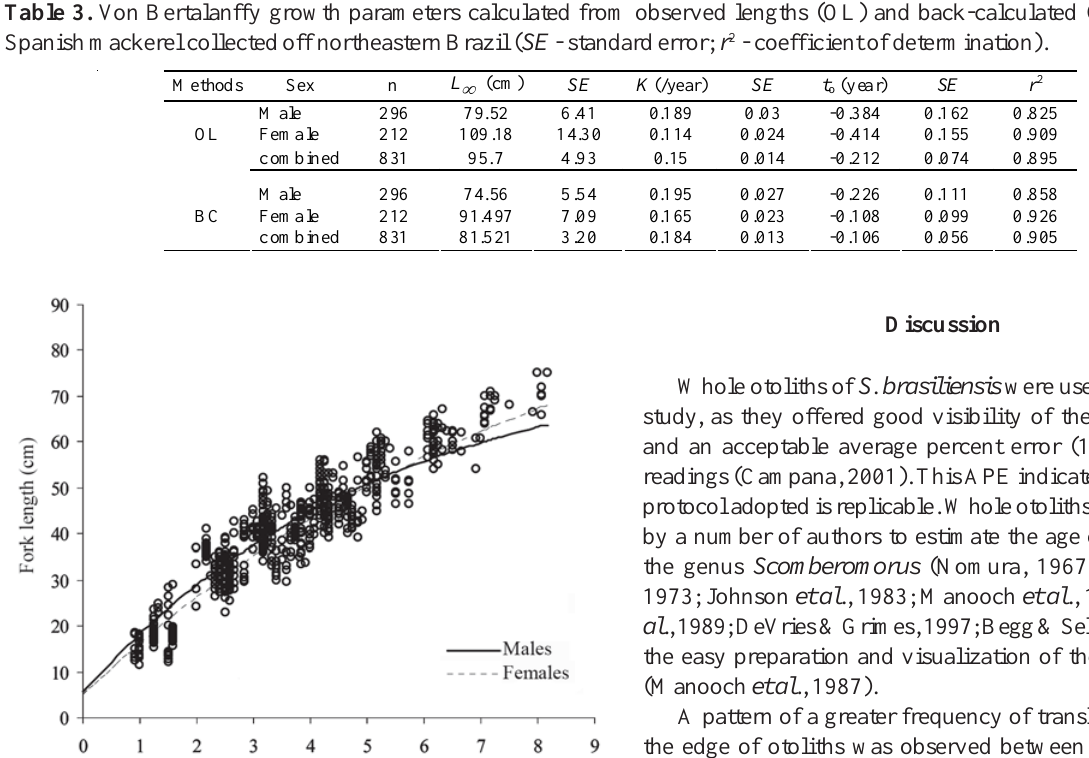
= second specified age; a = constant relative rate of relative growth rate; b = incremental 2 = size at age τ ; y = size at age τ ; z = relative growth rate at age τ 1 1 2 2 1